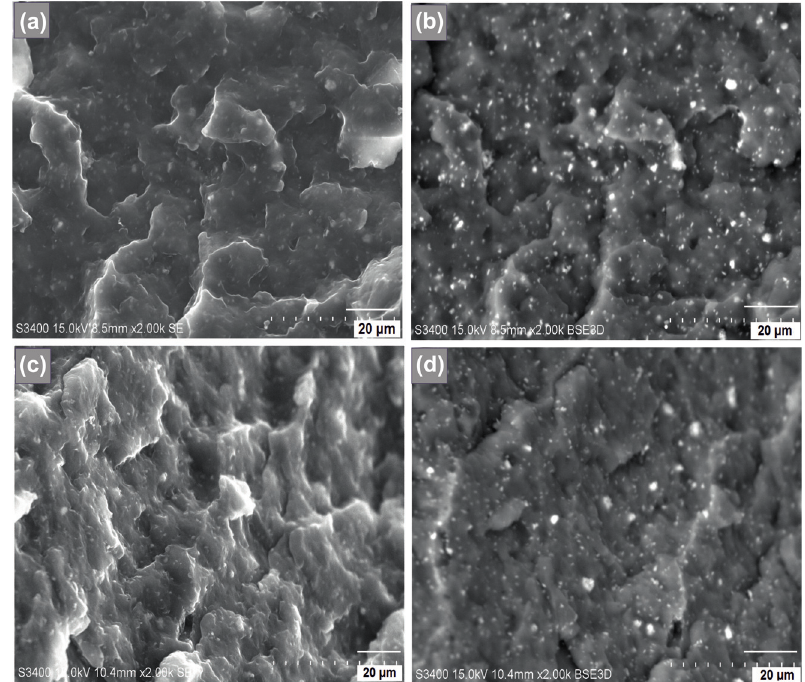
and (c, d) (BSE) unmodified PP/PP-g-MAH/10%Mg(OH) 2